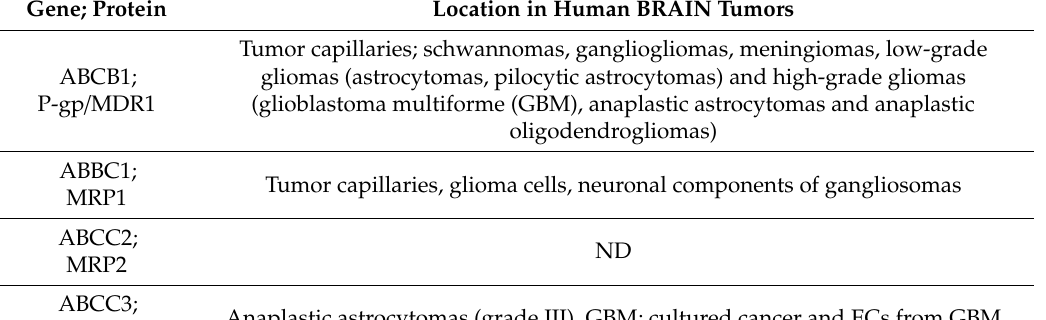
Table 3. ABC transporters expression in human brain tumors the brain and gliomas. Gene; Protein Location in Human BRAIN